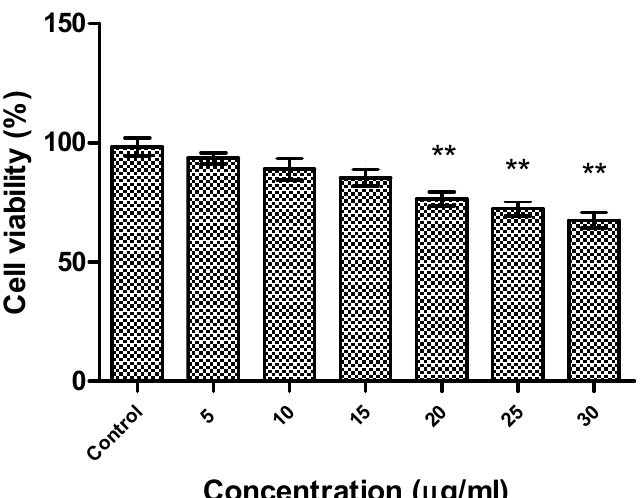
Figure 6. Cytotoxicity of R-phycoerythrin alpha subunit from Pyropia yezoensis analyzed in HepG2 cells. One-way ANOVA was performed to understand the significant difference between the control group and the R-PE alpha subunit-treated groups. The R-PE alpha subunit treated groups (20, 25, and 30 μ g/mL) showed significance activity, ** indicates ( p < 0.01).